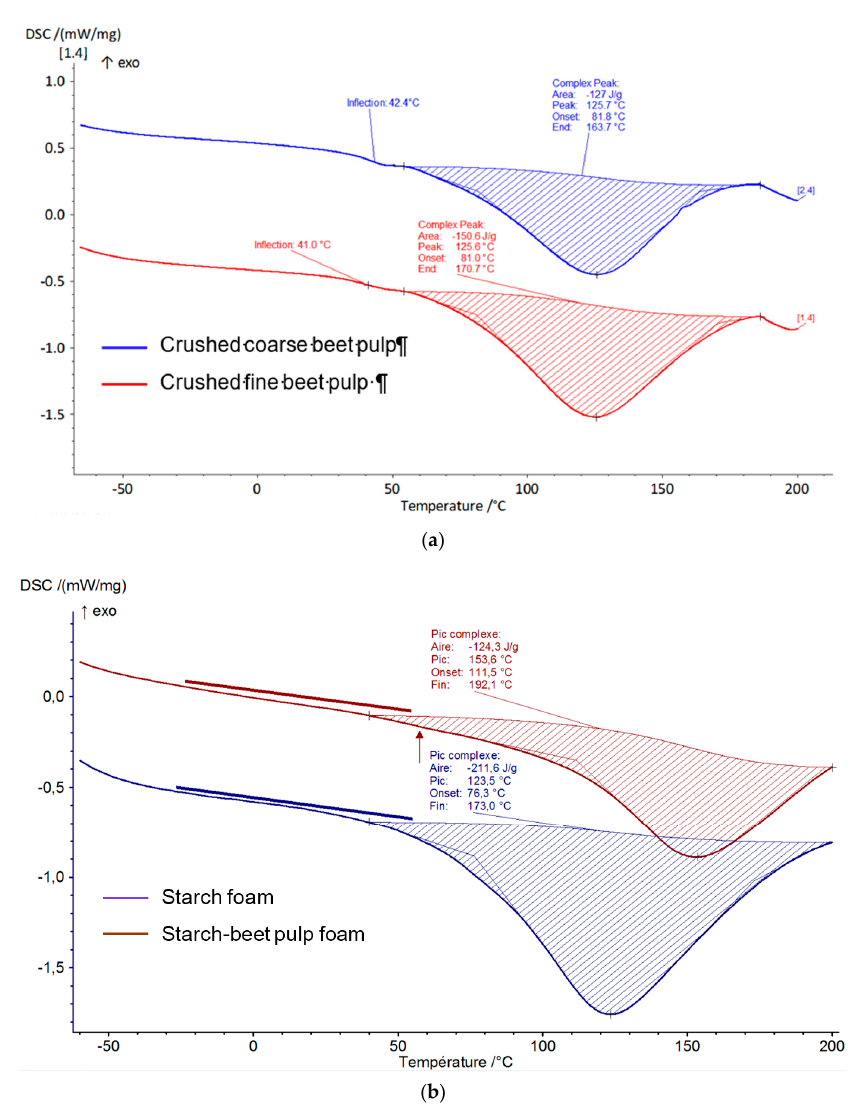
Figure 12. DSC thermograms: ( a ) beet pulp; ( b ) starch and starch-beet pulp foams.